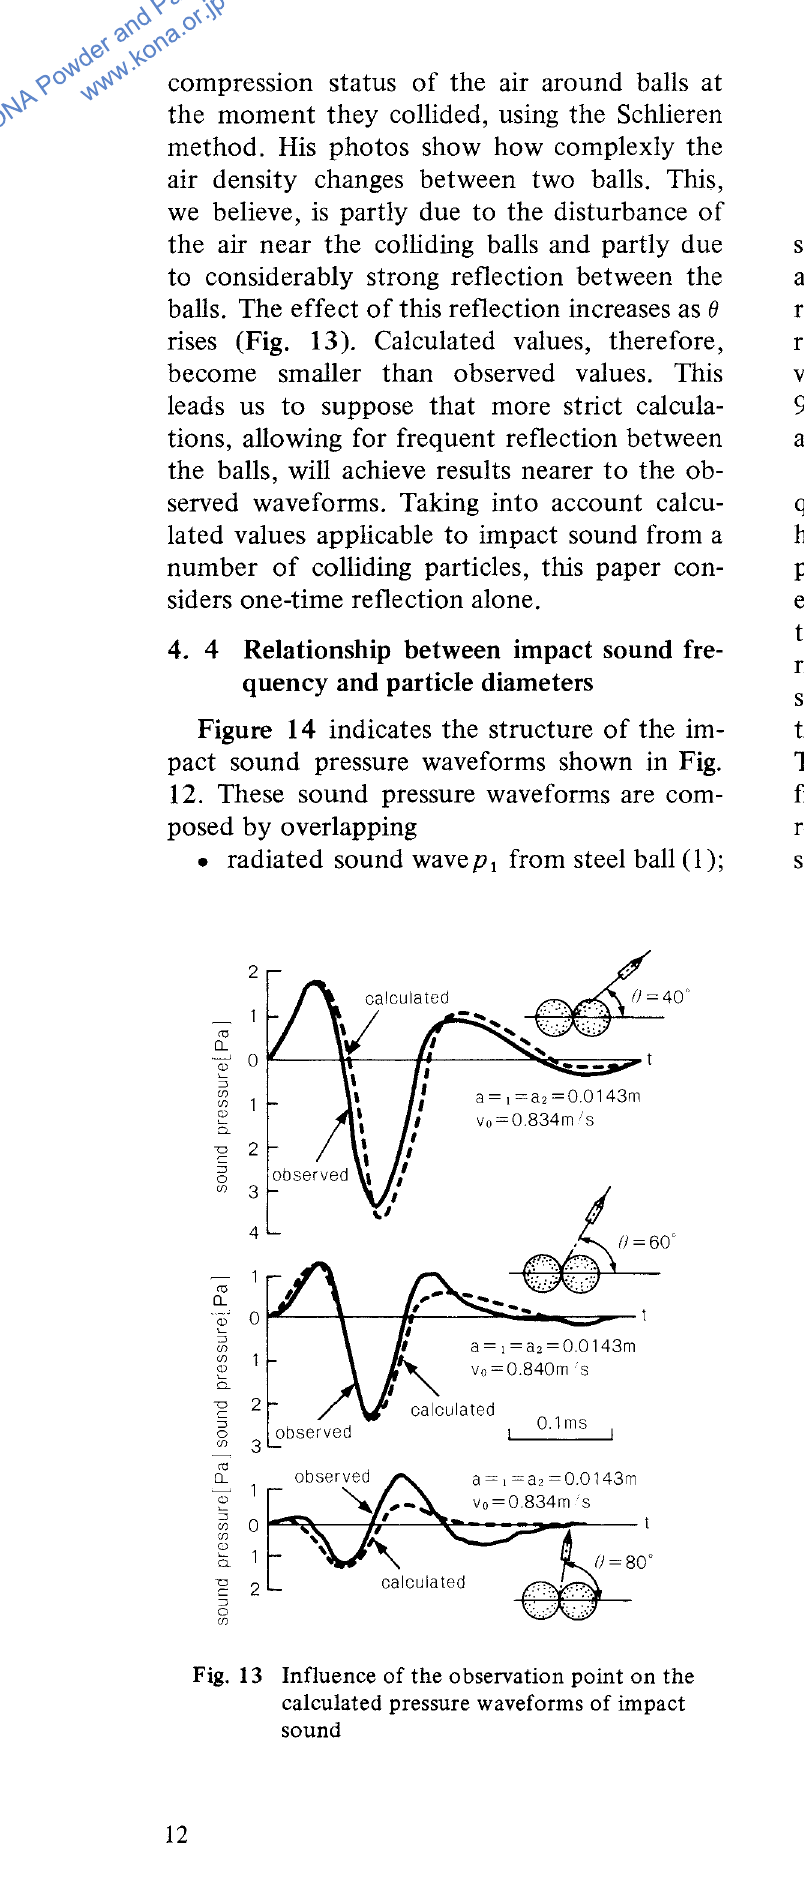
Fig. 14 Calculated pressure waveforms of impact sound